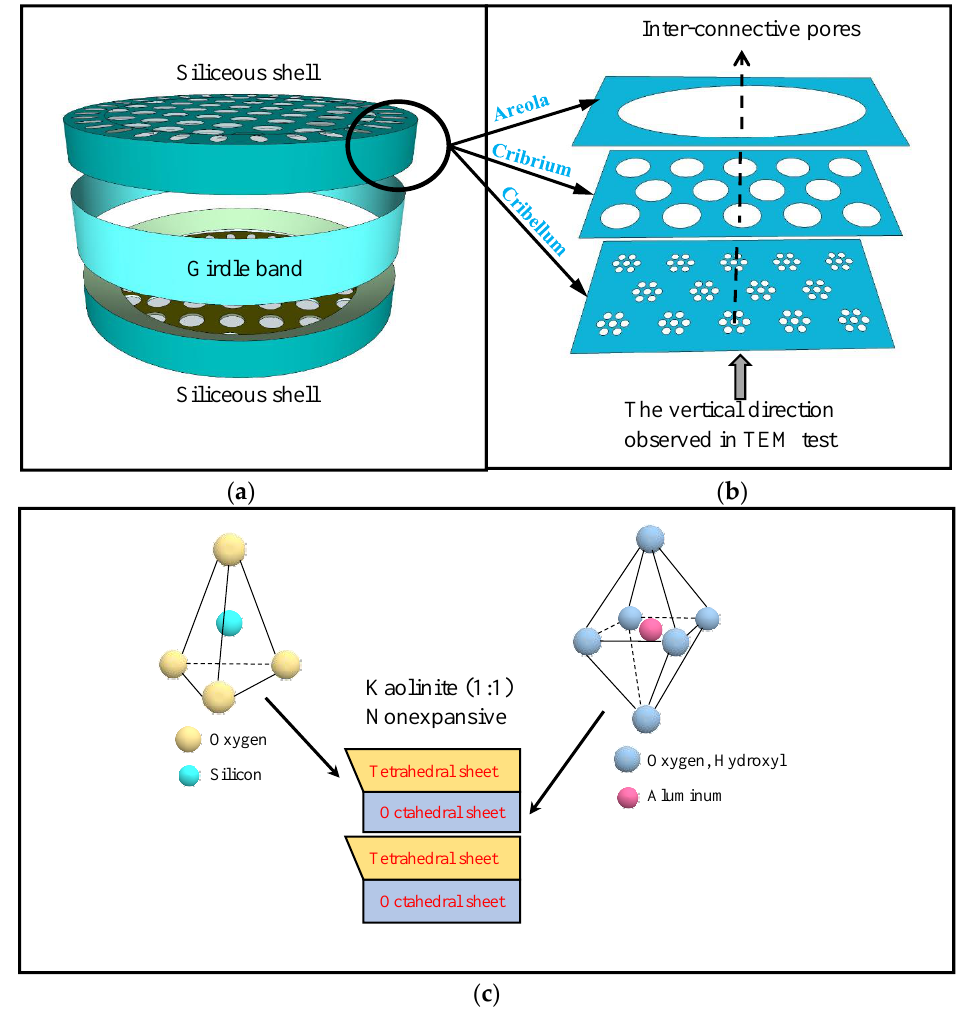
Figure 11. Schematics of ( a ) disk-shaped diatom frustule, ( b ) profile structure of frustule, and ( c ) crystal structure of kaolinite.